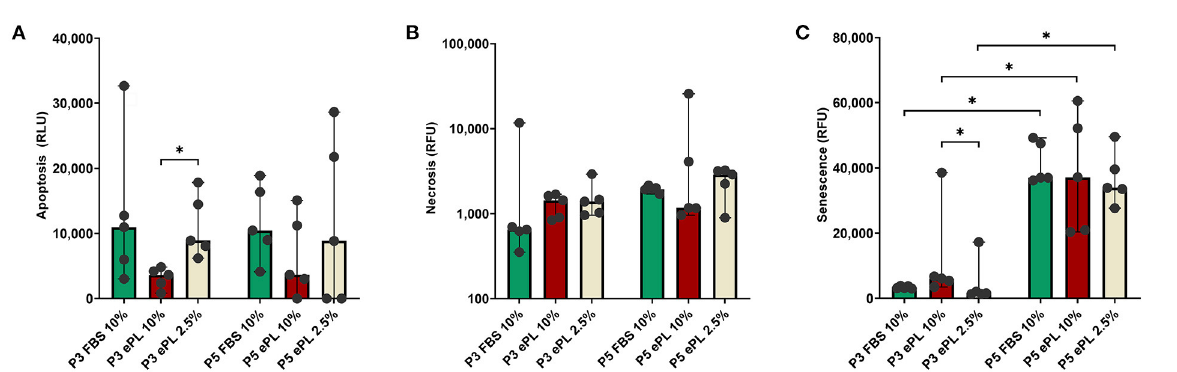
FIGURE1 Apoptosis (A) , necrosis (B) , and senescence (C) levels in equine mesenchymal stromal cells (MSC) cultured with 10% fetal bovine serum (FBS), 10% equine platelet lysate (ePL) or 2.5% ePL as medium supplements, in passage (P) 3 and 5. Apoptosis was measured by a